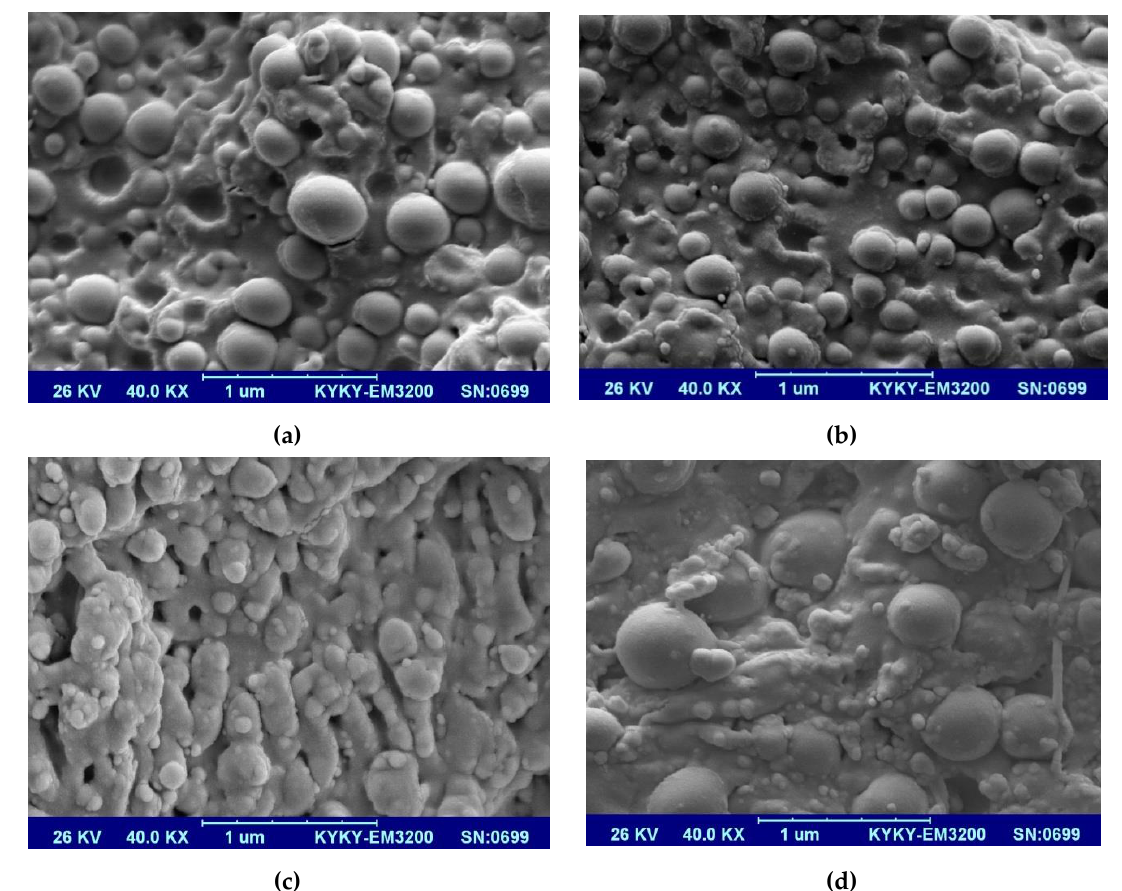
Figure 2. The SEM images of ethylene–propylene copolymer (EPC) and its nanocomposites ( a ) EPC, ( b ) EPC/SiO 2 (1%), ( c ) EPC/SiO 2 (3%) and ( d ) EPC/SiO 2 (5%).